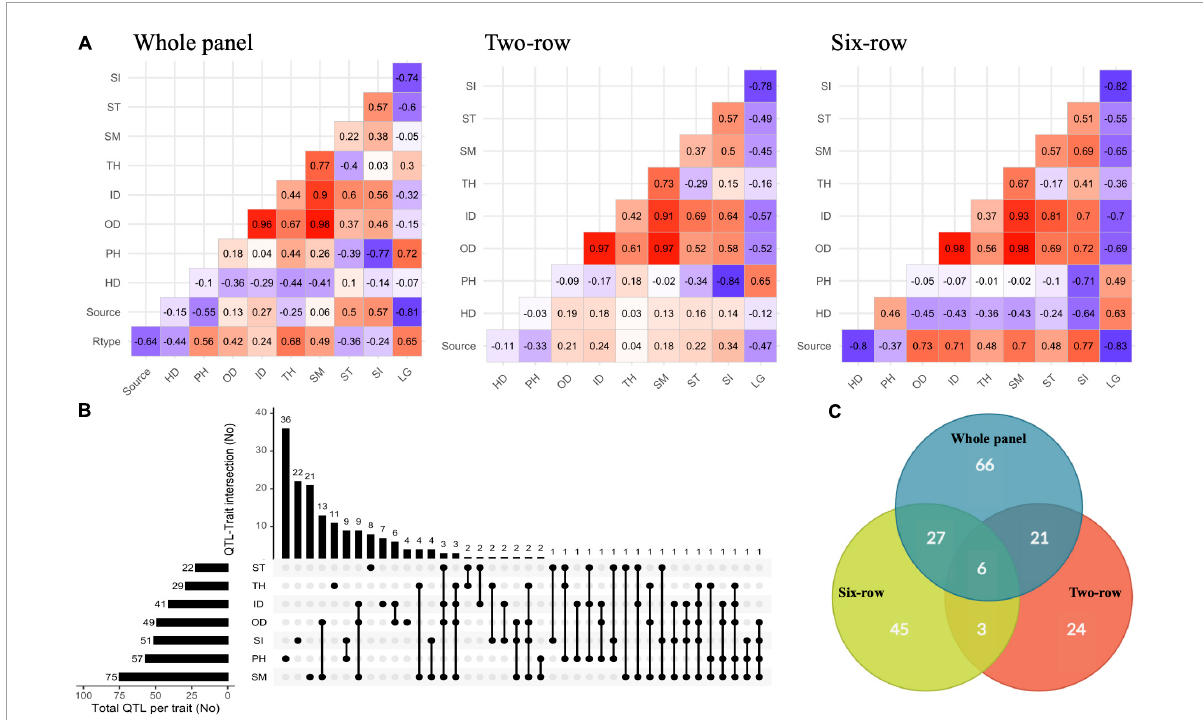
FIGURE2 (A) Pairwise phenotypic correlations between traits along with row type and germplasm sources within whole panel and row type groups based on means estimated across trials. (B) UpSetR plot showing the overlap of the associated SNPs/loci for traits identified by GWAS. (C) Venn diagram showing distribution of QTLs among whole panel and row type groups. Rtype, spike row type (two-row or six-row); Source, germplasm source (cultivar or landrace); HD, heading date; PH, plant height; OD, outer diameter; ID, inner diameter; TH, thickness; SM, section modulus; ST, stiffness; SI, stem index; LG,